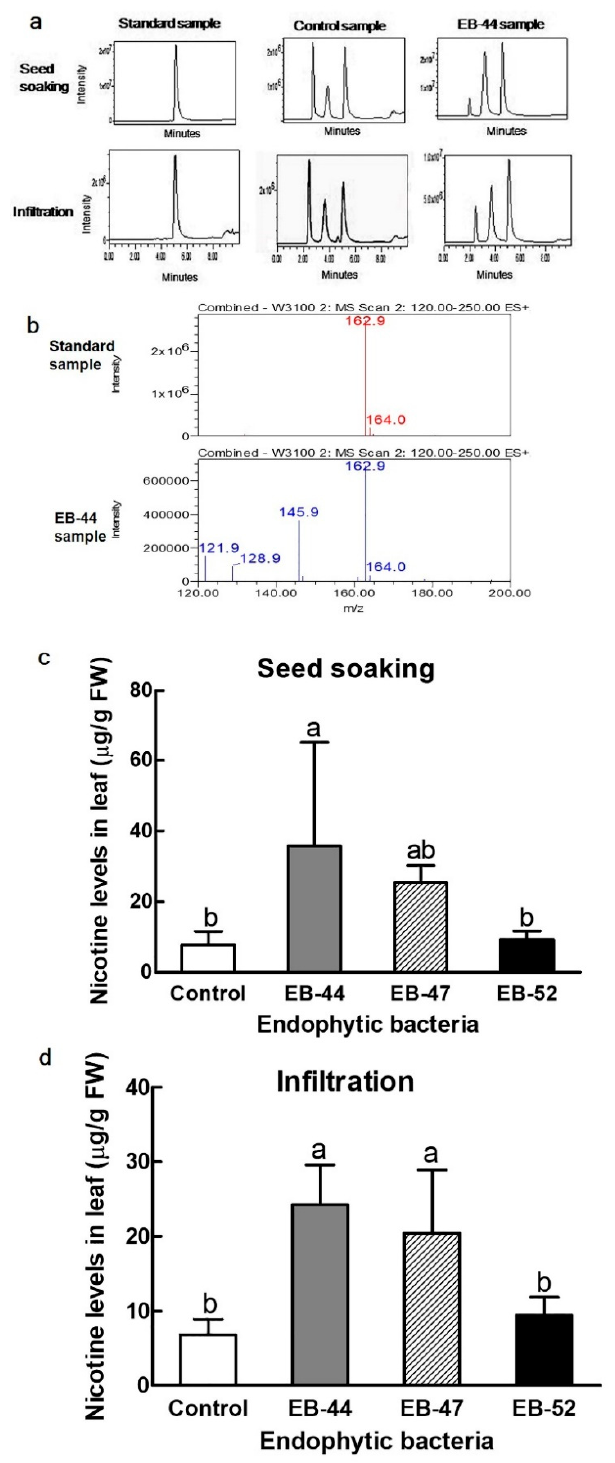
Figure 5. Liquid chromatography–mass spectrometry (LC–MS) analysis for the identification and quantification of nicotine levels in the leaves of Nicotiana benthamiana treated with salicylic acid (SA)-producing endophytic bacteria (EB). ( a ) LC–MS chromatograms of the standard, control, and EB-44 samples with matching nicotine peaks at 5.04 min. ( b ) Mass spectra profiles of the matching (162.9 m / z ) nicotine standard and EB-44. ( c , d ) Nicotine contents in the leaves of N. benthamiana grown from seeds treated with SA-producing EB or by leaf infiltration. Data represent means ± standard deviations of four independent replications for each treatment. Means with different letters are significantly different at p < 0.05 by Duncan’s multiple range test. FW = fresh weight.